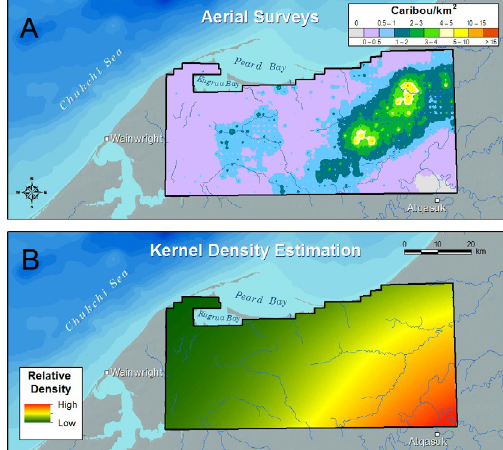
Figure 2. The estimated density of caribou based on aerial surveys conducted in mid-June 2013–2015 (A) and the relative density utilization distribution from kernel density estimation of telemetry data from Teshekpuk female caribou 2013–2015